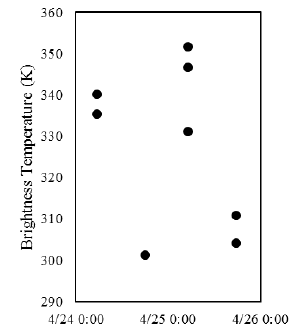
Figure 5 . Fire pixels in terms of brightness temperature (K) in Benguet, Philippines by VIIRS.